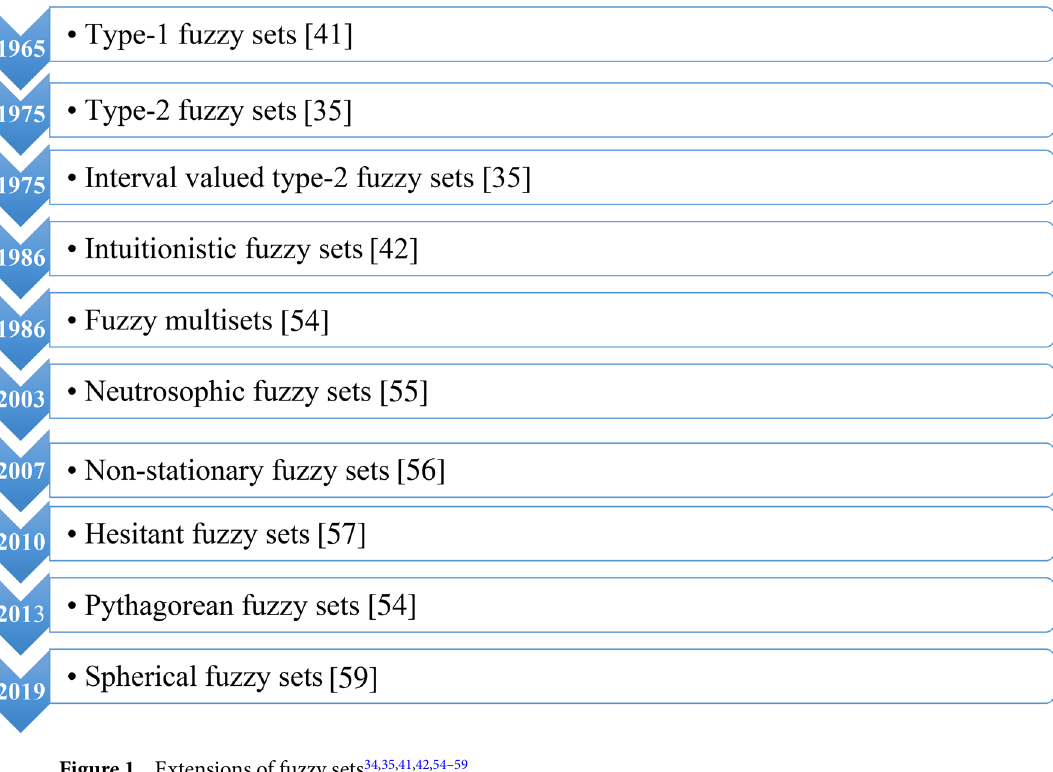
Figure 1. Extensions of fuzzy sets 34,35,41,42,54–59